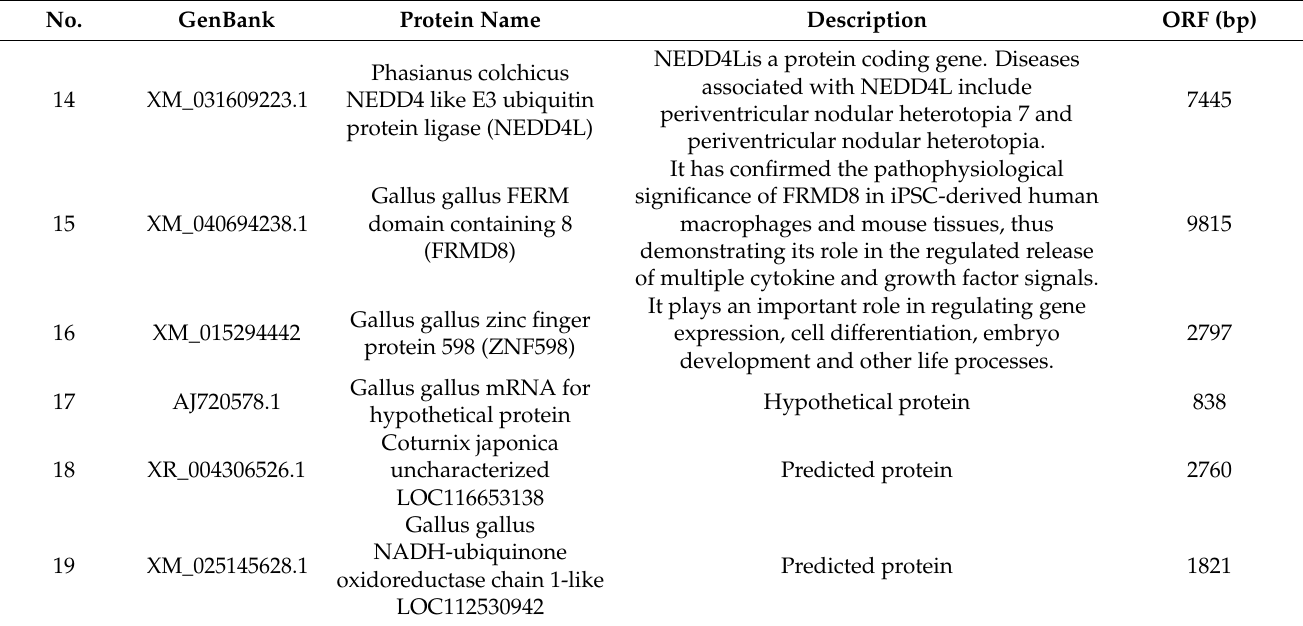
and translation regulators. The five main CC subcategories were cell, organelle, cell parts, protein-containing complex and bindings (Figure 2A). In addition, 26 KEGG pathways were obtained for the identified proteins. The pathways of metabolism, genetic information processing, environmental information processing and diseases were associated with the highest numbers of identified proteins (Figure 2B).